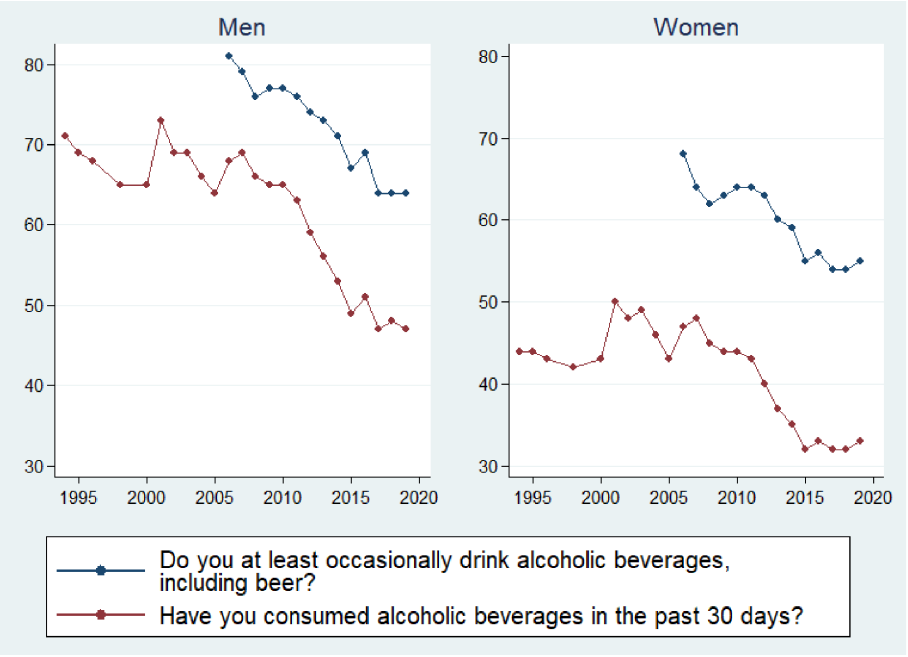
Figure 1. Prevalence of alcohol consumption according to RLMS, men and women, 1994-2018, %. Source : author’s calculations based on the RLMS